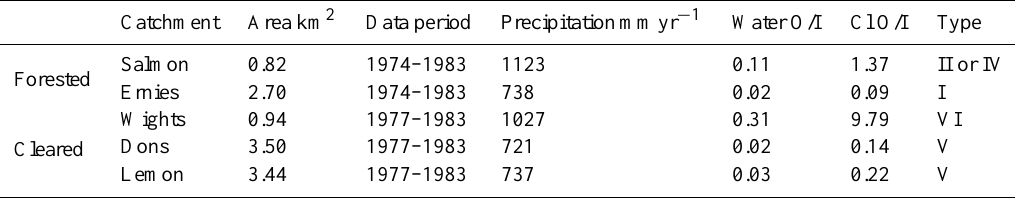
Table 1. Water and chloride ratios of five experimental catchments in (Williamson et al., 1987) and their corresponding chloride equilibrium types (The forest clearance occurred at the end of 1976. All quantities were measured during the data period).